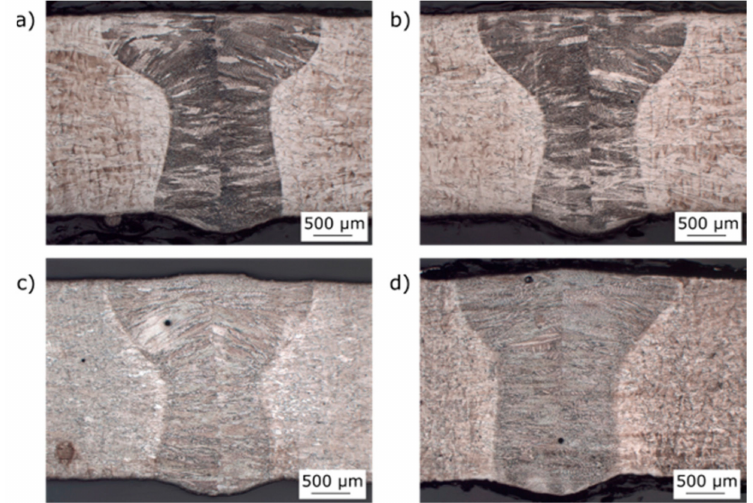
Figure 12. Cross sections of SLM manufactured tubes of IN625 and IN718: ( a ) IN625_HT_SLME,